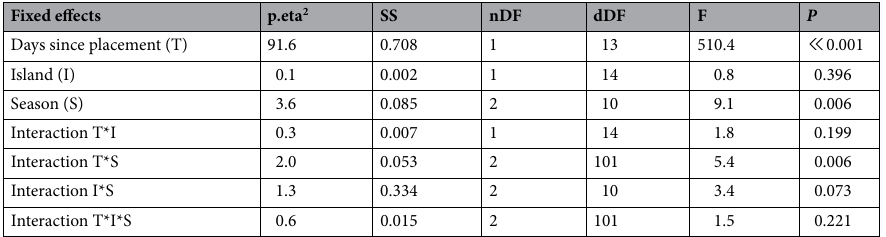
Table 2. Three-way random intercept and random slopes mixed model analysing the decomposition score of large birds in three different seasons (summers, late autumn and early spring) and two study areas (islands of Lanzarote and Fuerteventura). p.eta 2 , Partial eta squared measuring the proportion of variance accounted for by a given fixed effect after accounting for that explained by other predictors in the model; SS, Sums of squares. nDF, Numerator degrees of freedom of the fixed effects (days since the placement of carcasses in the field has been treated as an ordinal factor, thus having one degree of freedom in the linear contrast of its levels). dDF, Denominator degrees of freedom using the Kenward–Roger method.